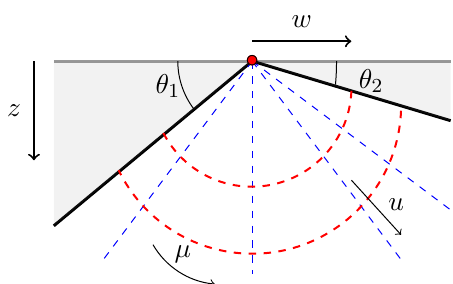
Figure 1. An illustration of wedge holography: the bulk geometry is a part of empty AdS d +1 between two end-of-world Karch-Randall branes (black lines), meeting each other on the conformal boundary of AdS d +1 at their common boundary (the red dot). The bulk shaded regions behind the branes are removed, leaving only a wedge in the bulk. Wedge holography states that the gravitational physics in the bulk wedge is dual to a conformal field theory living on the red dot (the